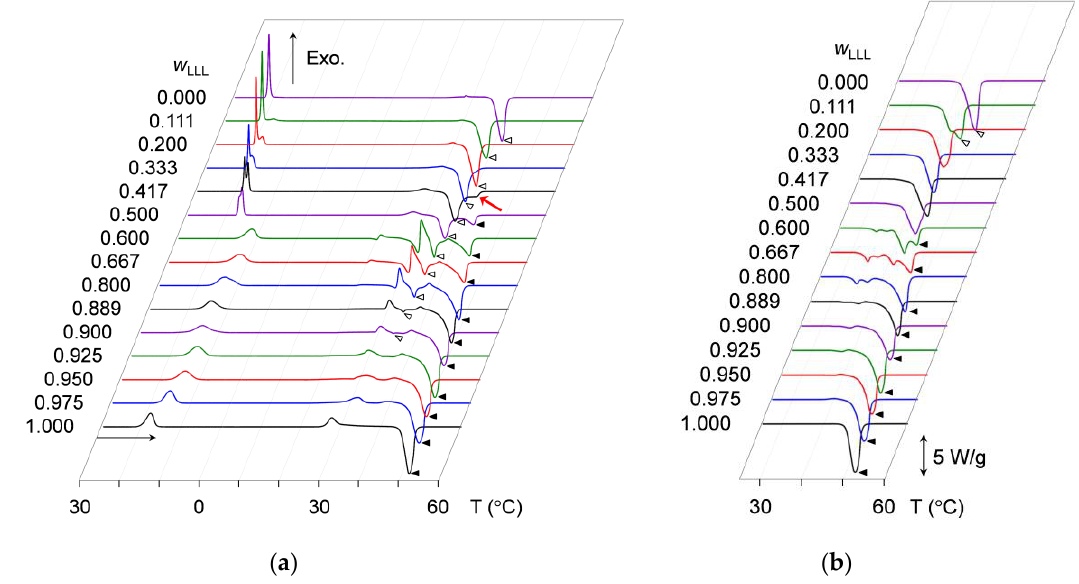
Figure 1. Di ff erential scanning calorimetry (DSC) thermograms of mixtures of SOS with LLL (SOS / LLL) at several mass fractions of LLL ( w LLL ). Open triangles denote endothermic peaks for SOS at the highest peak-top temperature, and closed triangles denote those for LLL. ( a ) Thermograms taken during constant-rate cooling (2 ◦ C / min) and subsequent heating (5 ◦ C / min); ( b ) thermograms taken during constant-rate heating (5 ◦ C / min) after aging at 25 ◦ C for two